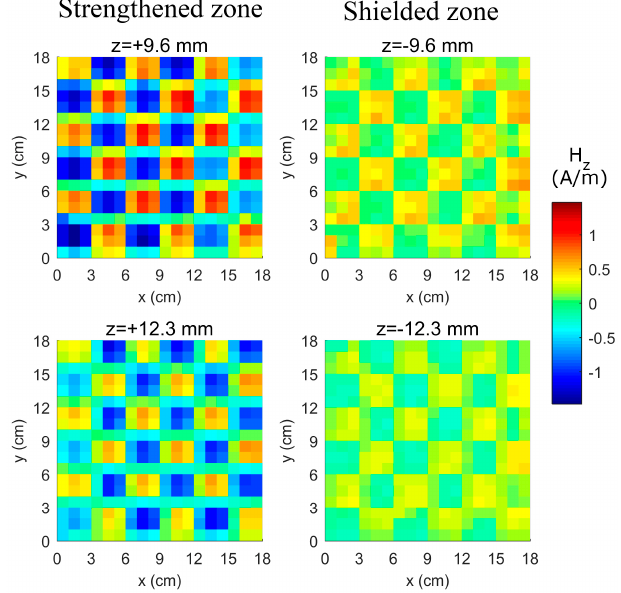
Figure 7. Magnetic radiation map at z = ± 9.6 mm and ± 12.3 mm. The power transferred to the shorted probe on the top side is 15 times greater than that transferred to the bottom side.